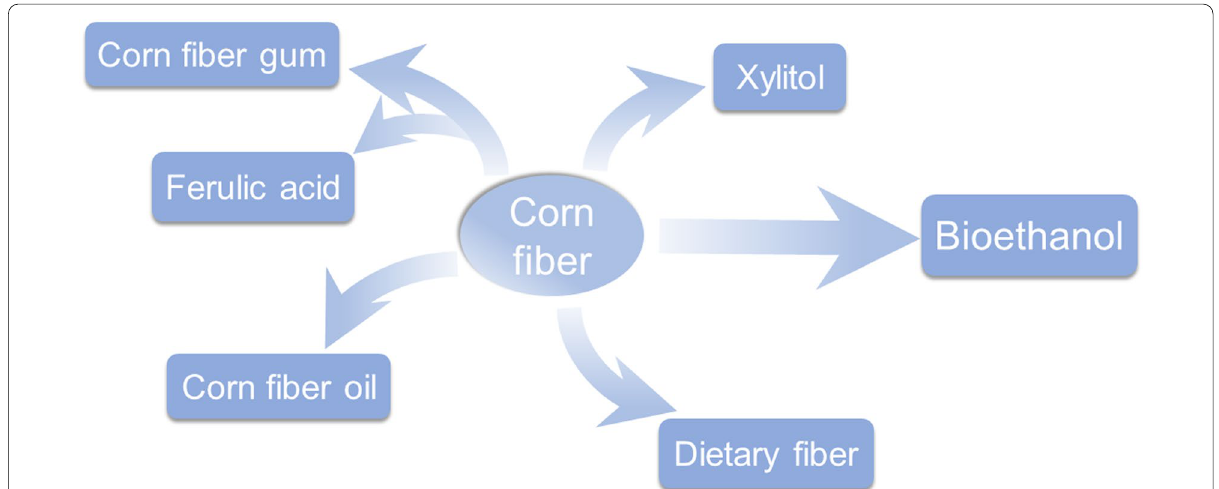
Fig. 1 Biorefining of corn fiber to produce fuel and other value-added products